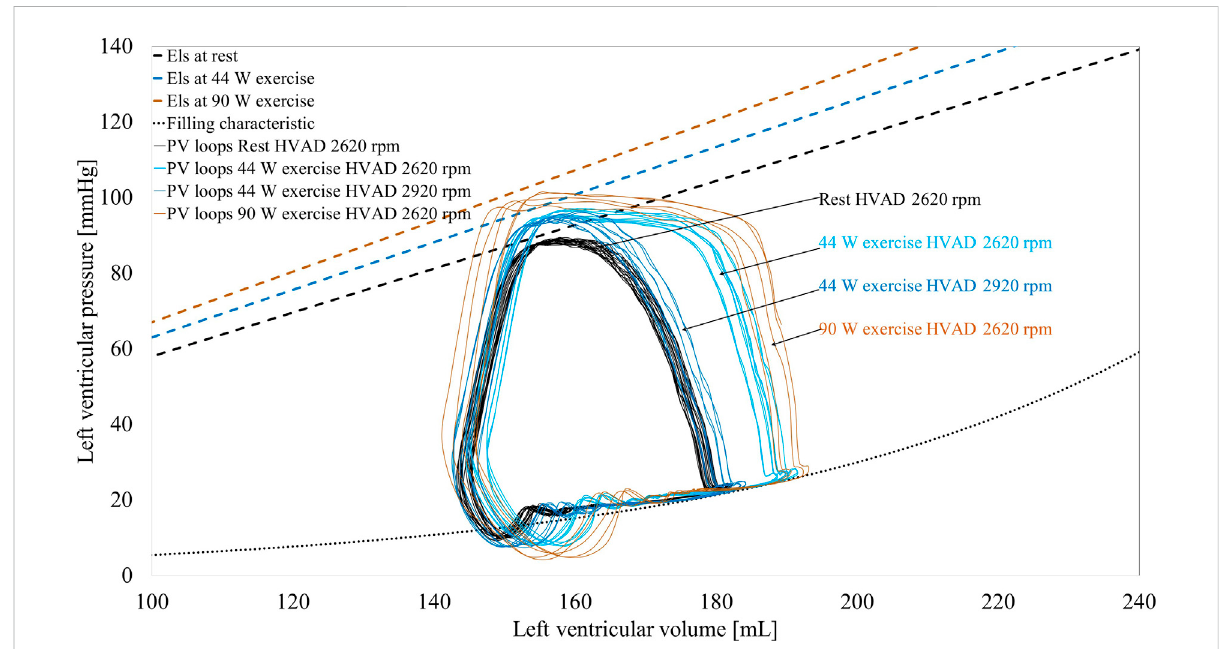
FIGURE 8 Simulatedventricularpressure-volumeloopsoftheleftventriclesupportedbyanHVADfordifferentconditions.Alsotheend-systolicelastance ( Els ) and the diastolic fi lling curves of the left ventricle are